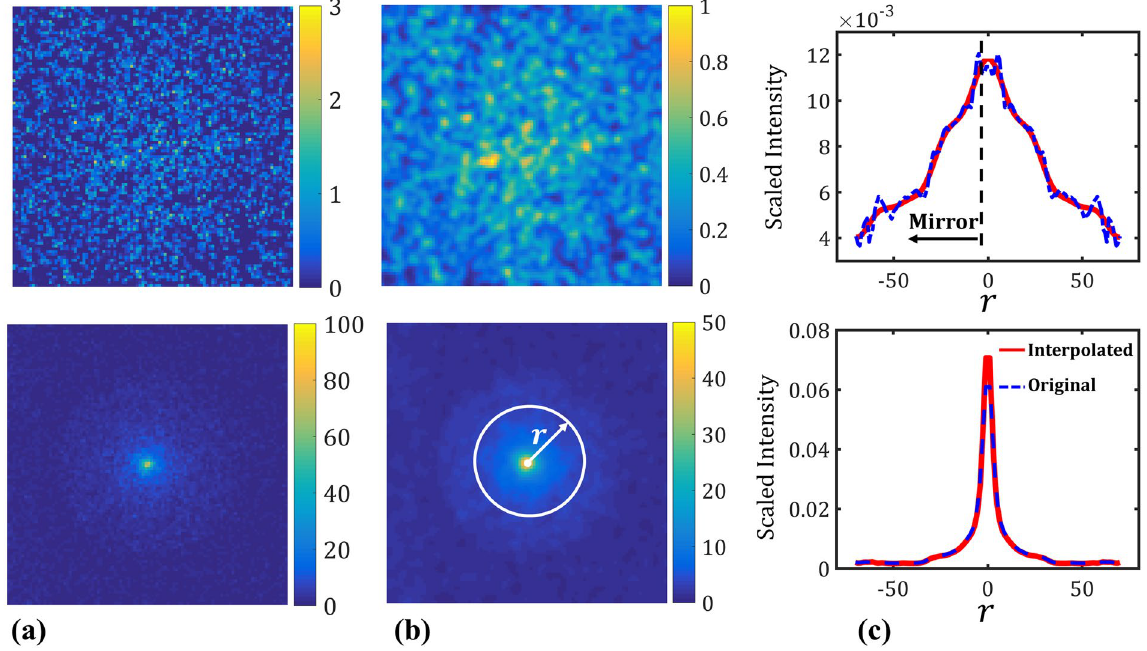
Figure 2. Measuring σ for two different images: ( a ) The original scattering patterns obtained by Zemax following the schematic in Fig. 1. Both images have a side length of 100 pixels. The simulation settings (i.e., = x t g s [ , , ] ) for the images on the top and bottom row correspond to [51 1, 0 75, 0 04] . . . and l . . . [24 4, 0 83, 0 1] , respectively. The color bars indicate the range of gray intensity for each image. ( b ) The filtered images. The same Gaussian kernel is used to filter out the local noises in both images in panel ( a ). ( c ) The scaled radial distribution of gray intensity. The area under the dashed blue curve is approximately unity in both cases and the solid red curves are the regressors fitted to the original data. While in the top plot the noise is considerable (even after filtering with a Gaussian kernel), in the bottom plot the noise is negligible and hence the regressor almost interpolates. Gaussian processes are employed as regressors here with an estimated nugget of 10 − 3 and 10 − 5 for the top and bottom plots,